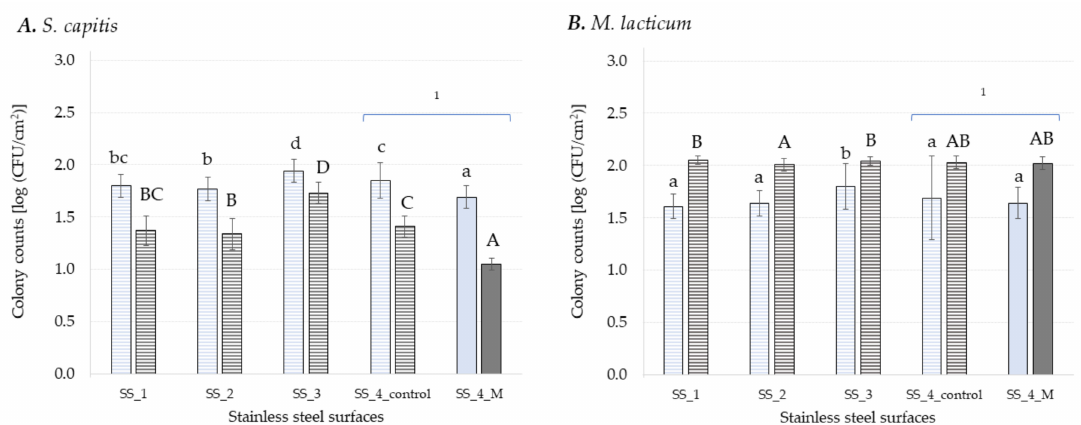
Figure 2. Log CFU cm − 2 of S. capitis ( A ) and M. lacticum ( B ) enumerated on different stainless steel surfaces after 3 h (light blue) and 48 h (dark grey) of incubation. Surfaces with antimicrobial coatings are colored with a solid fill and surfaces without antimicrobials are highlighted with a pattern fill. Different lowercase letters denote significant differences (multiple range test, p ≤ 0.05) between the respective samples during adhesion (3 h), while uppercase letters indicate differences in early-stage biofilm formation (48 h). Each experiment was repeated in at least triplicates. 1 Same SS surface with and without antimicrobial